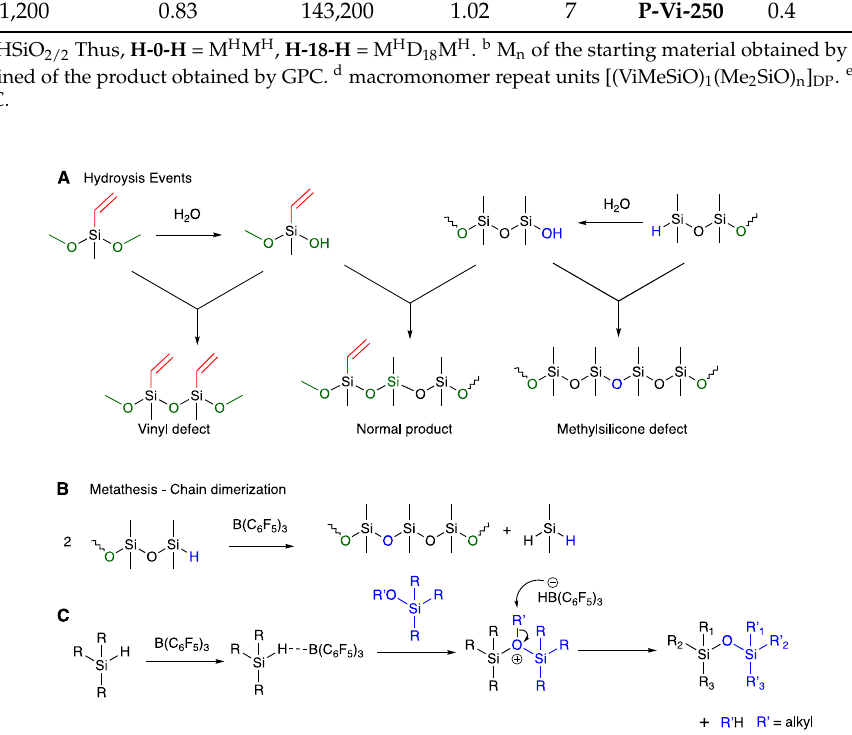
Figure 4. Origins of defects during chain extension. ( A ) Hydrolysis. ( B ) Metathesis. ( C ) Mechanism of the PR reaction.